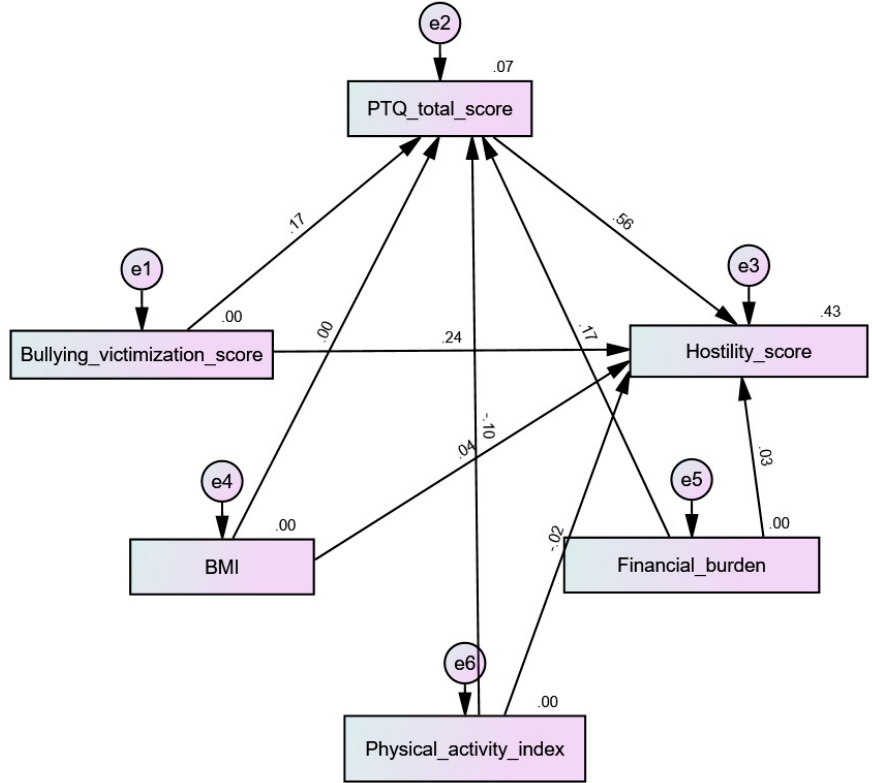
Children 2023 , 10 , x FOR PEER REVIEW